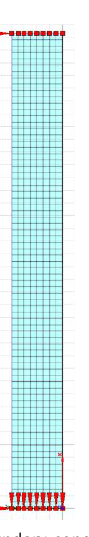
Fig. 9 Geometry, mesh and boundary conditions for the buckling